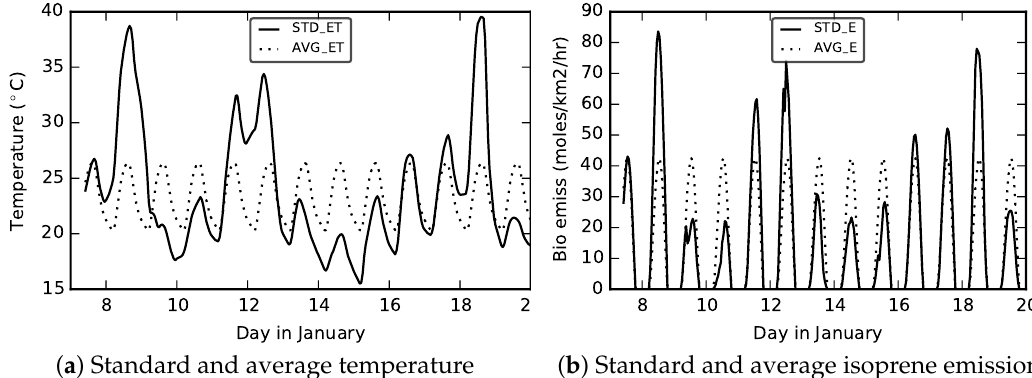
Figure 10. Standard and monthly averaged temperature and isoprene emissions.